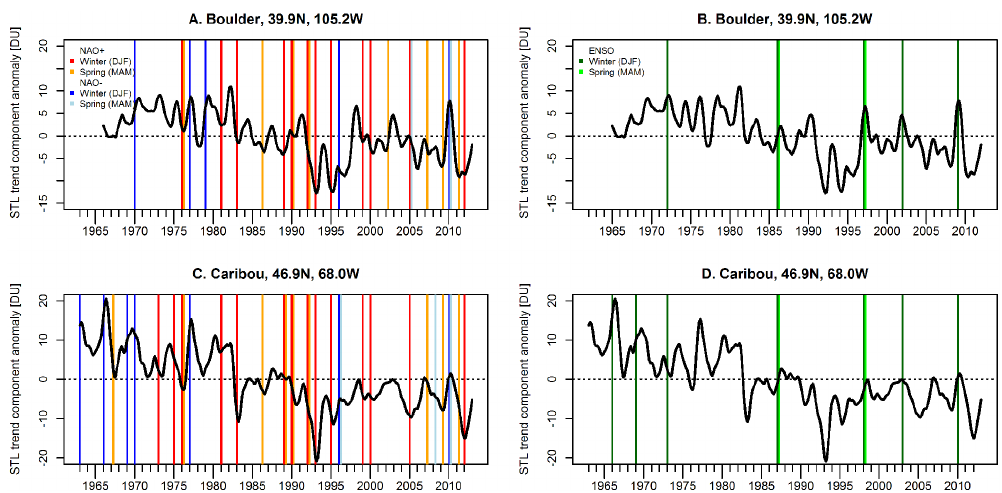
Figure 5. STL-trend component anomaly (in DU) in 1963–2012 for Boulder (top) and Caribou (bottom) with underlying marks (colored vertical bars) for fingerprints of positive and negative NAO modes (left panels) and warm ENSO phases (right panels) on a seasonal basis. NAO positive (negative) phase is indicated for winter in red (blue) and for spring in orange (light blue). The warm ENSO phase is indicated for winter in green and spring in light green.